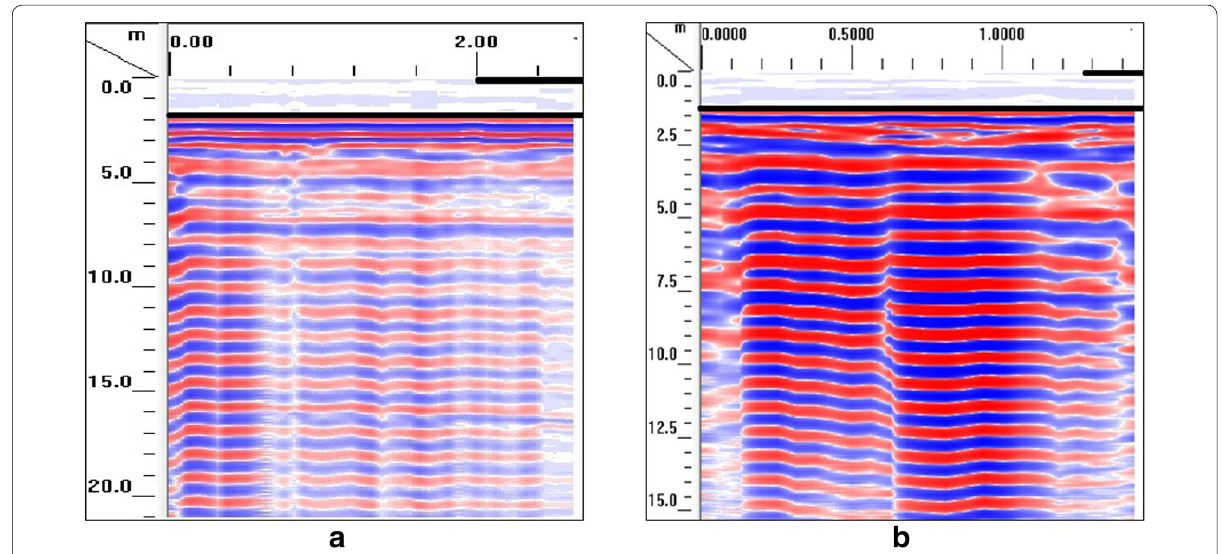
Fig. 7 GPR results at Mansadevi landslide area, Haridwar with a 80 MHz and b 35 MHz antenna